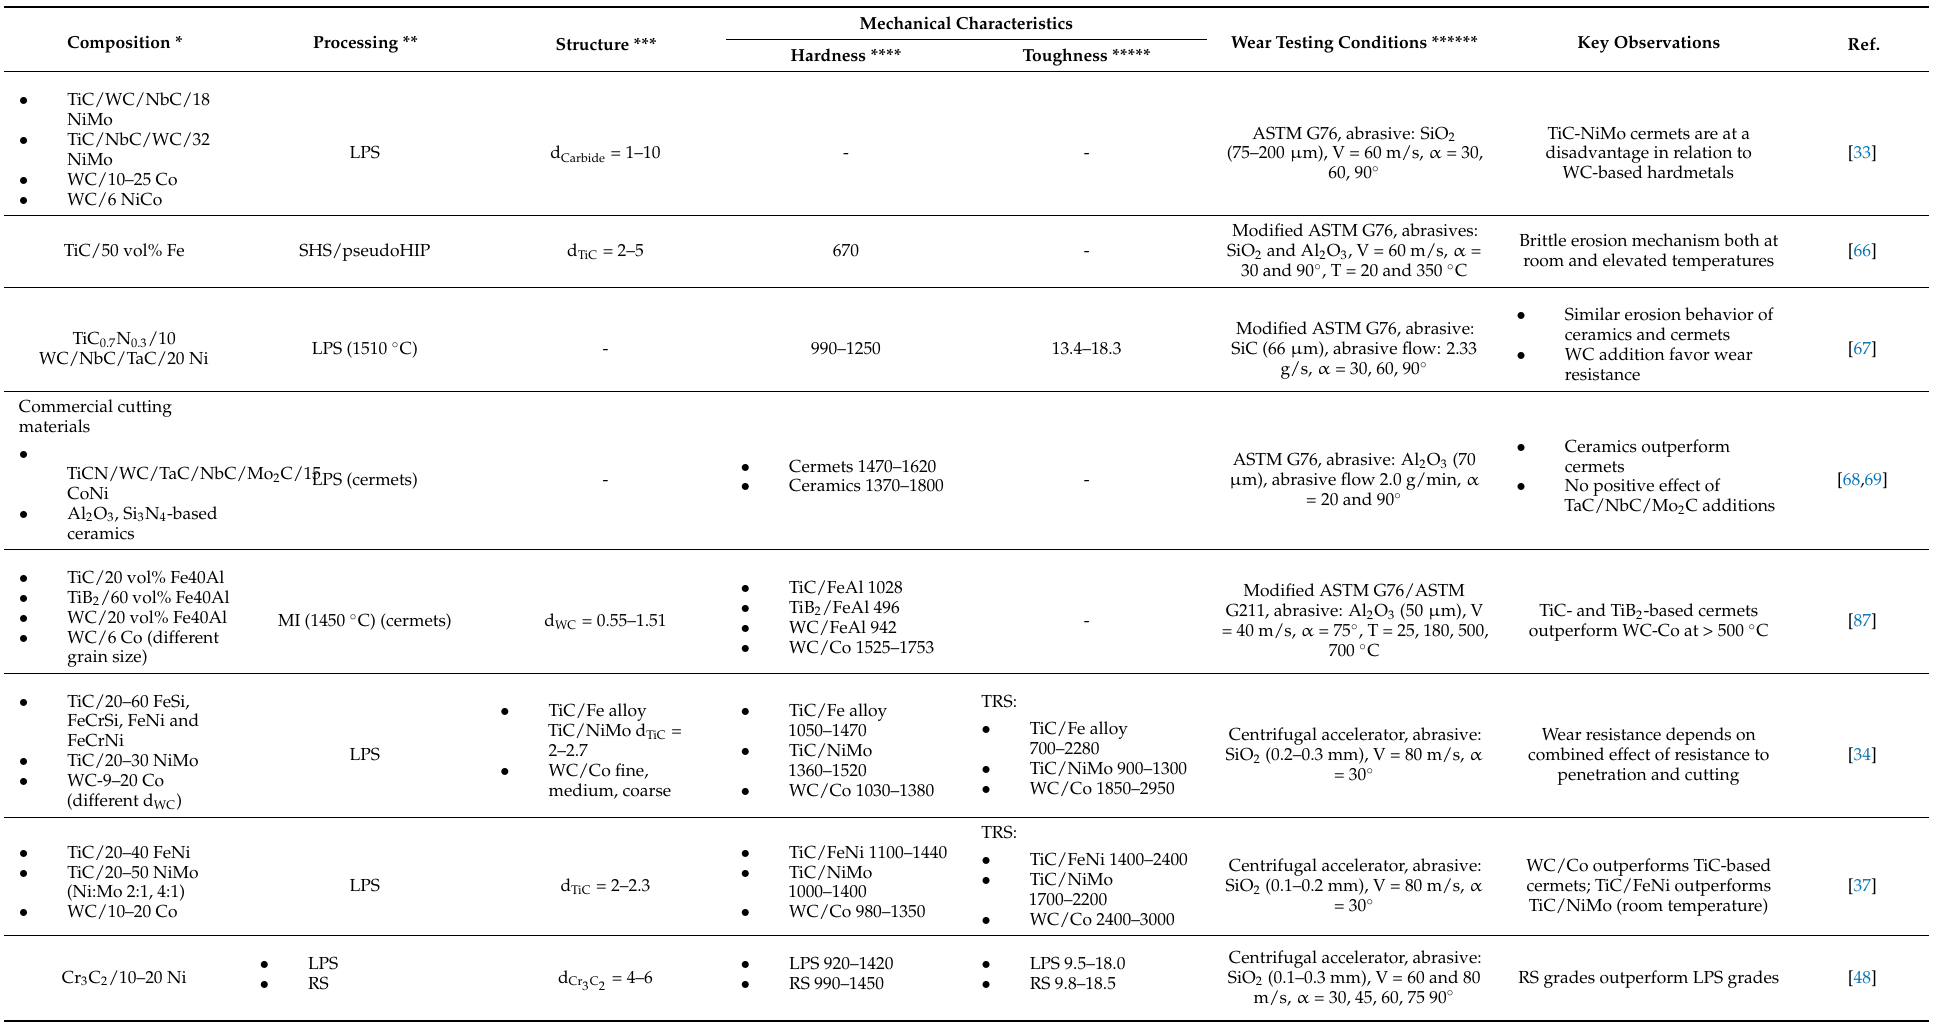
Table 3. Summary of composition, processing, structural and mechanical characteristics and solid-particle erosive wear testing conditions of